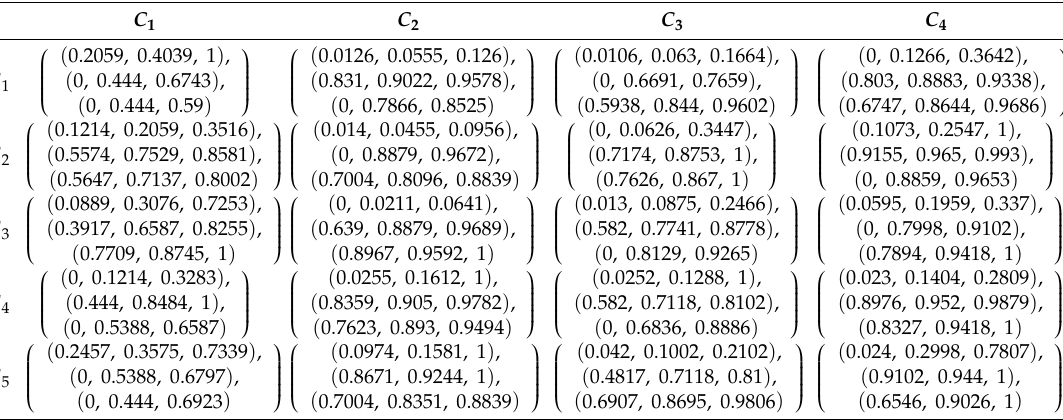
(cid:104) (cid:105) q j . 1 x 4